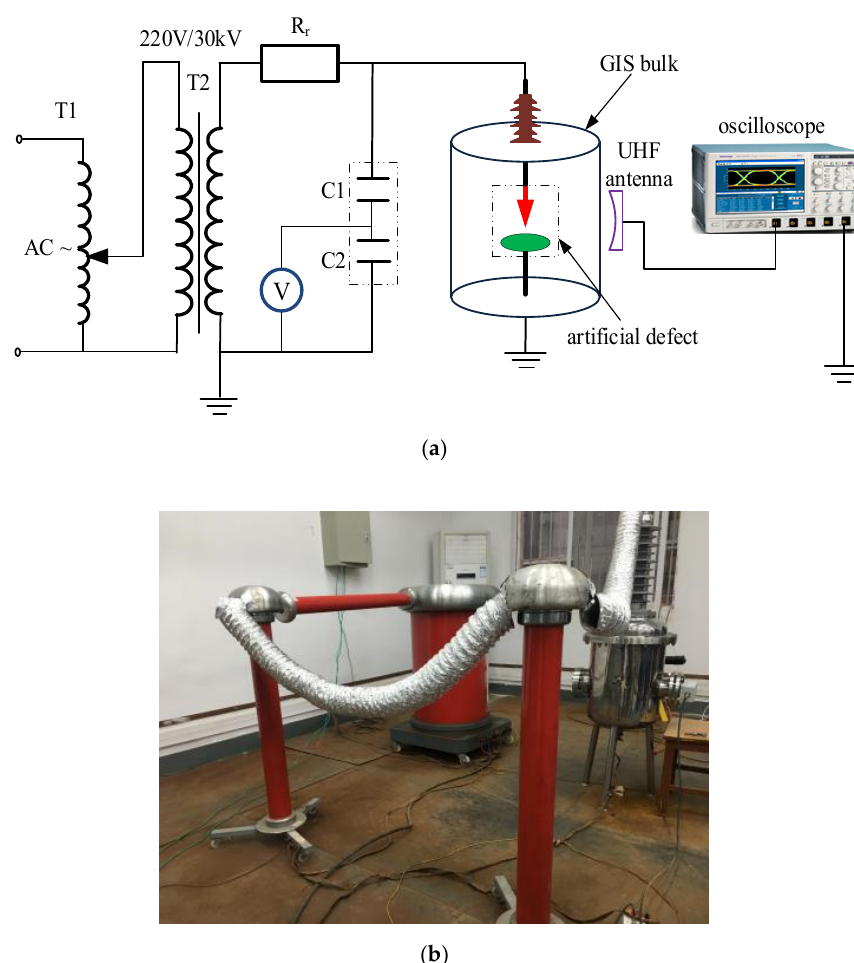
Figure 15. Experiment diagram. ( a ) Schematic diagram. ( b ) Measurement setup.